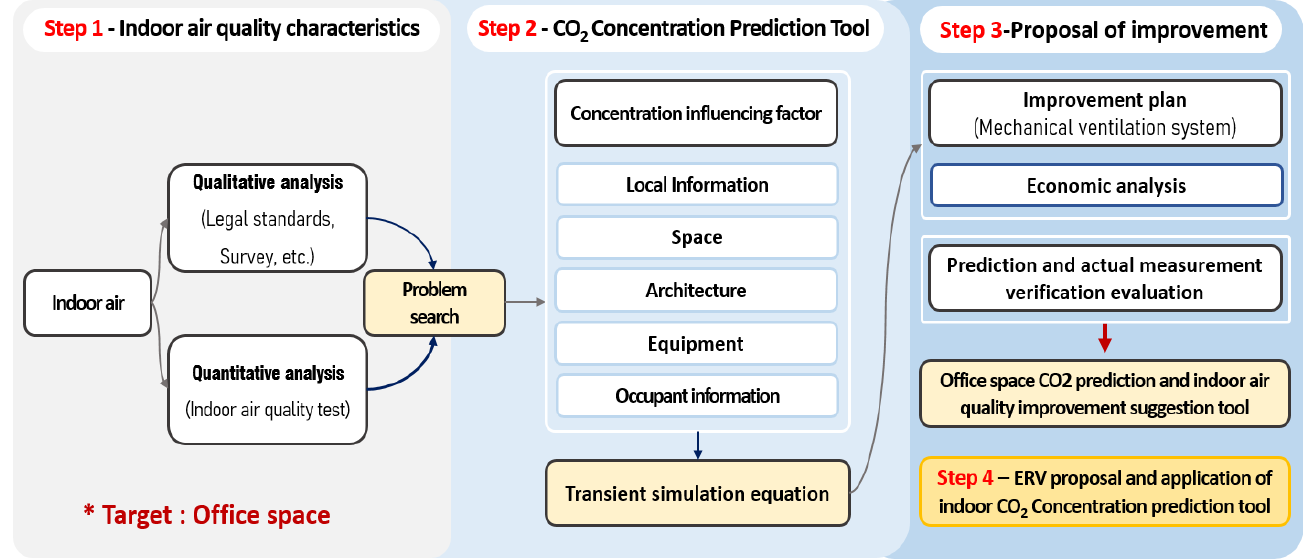
Figure 3. Research model and economic analysis of indoor CO 2 concentration prediction and the improvement proposal system reflecting characteristics of office occupants; * target: office